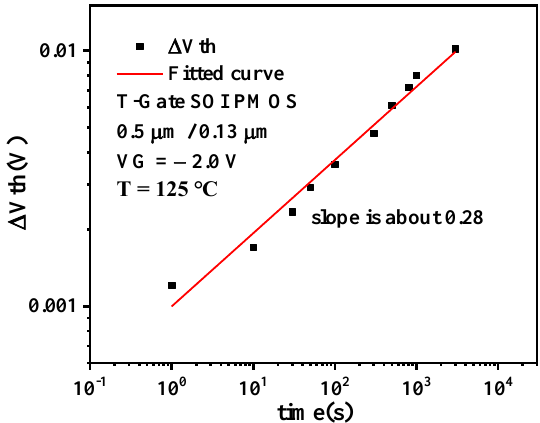
Figure 8. Δ V th degradation dependence on the stress time. Figure 8. ∆ V th degradation dependence on the stress